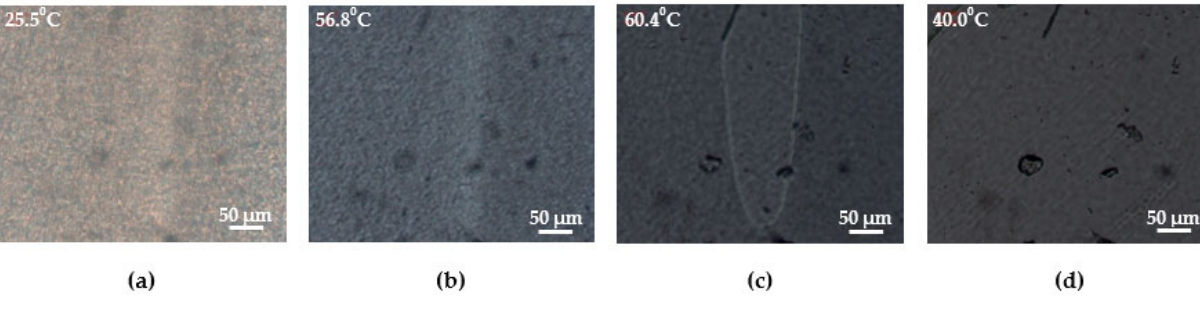
Figure 11. POM micrographs of the multiblock PUU of the composition S6 made at different tem ‐ peratures: 25.5 ( a ), 56.8 ( b ), 60.4 ( c ), and 40.0 °C ( d ).